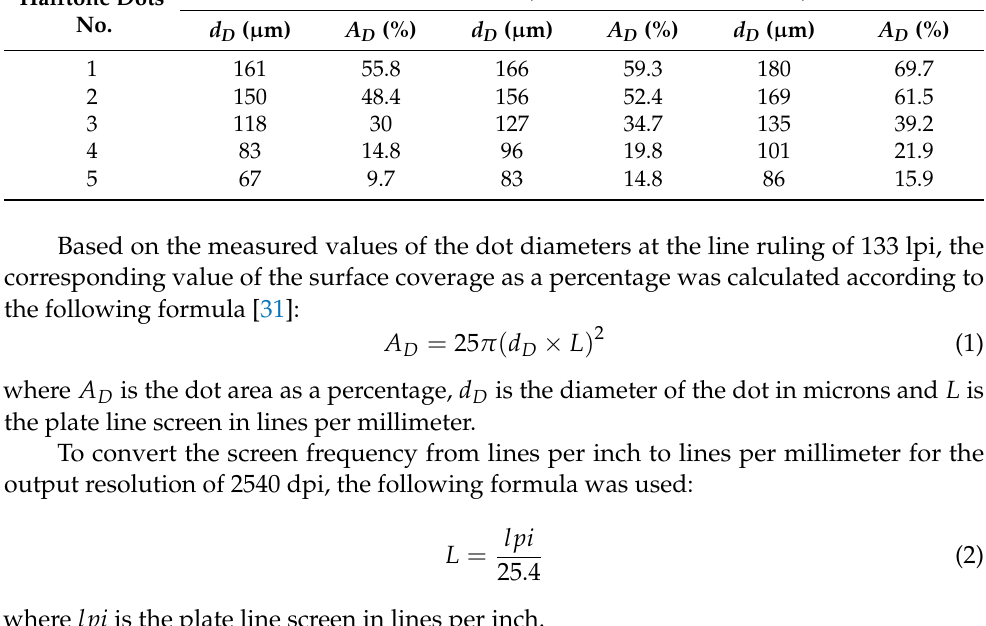
Figure 5. Absolute increase of dot coverage values for five selected halftone dots at Stage II and Stage III.